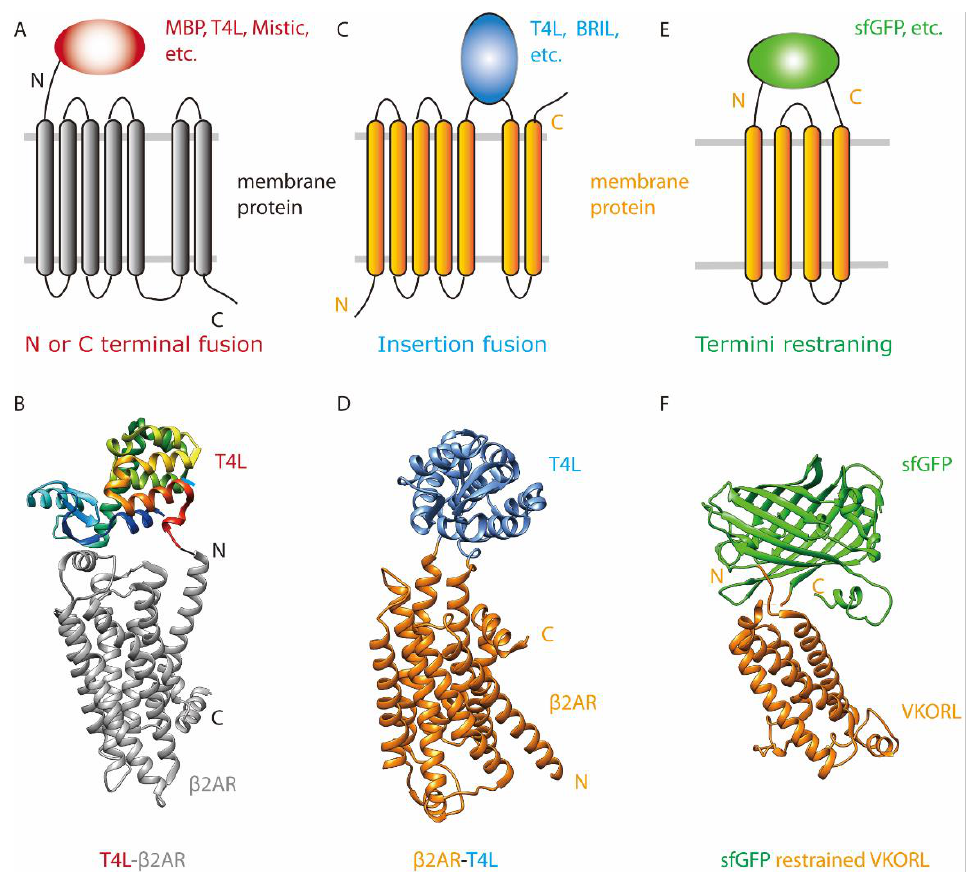
Figure 2. Protein fusion methods for the crystallization of membrane proteins. Membrane proteins are colored in grey or orange and the scaffold proteins in red, blue or green. ( A ) Scheme of N or C terminal fusion. The scaffold protein is fused to one end of a membrane protein. ( B ) Example of terminal fusion. T4L is fused to the N- terminus of the β2 adrenergic receptor (T4L - β2AR). PDB: 4GBR. ( C ) Scheme of insertion fusion. The scaffold protein is fused between the TMs. ( D ) Example of insertion fusion. T4L is fused between the TM5 and TM6 of human β2 adrenergic receptor (β2AR - T4L). PDB: 2RH1. ( E ) Scheme of termini restraining. The scaffold protein is fused to the two termini